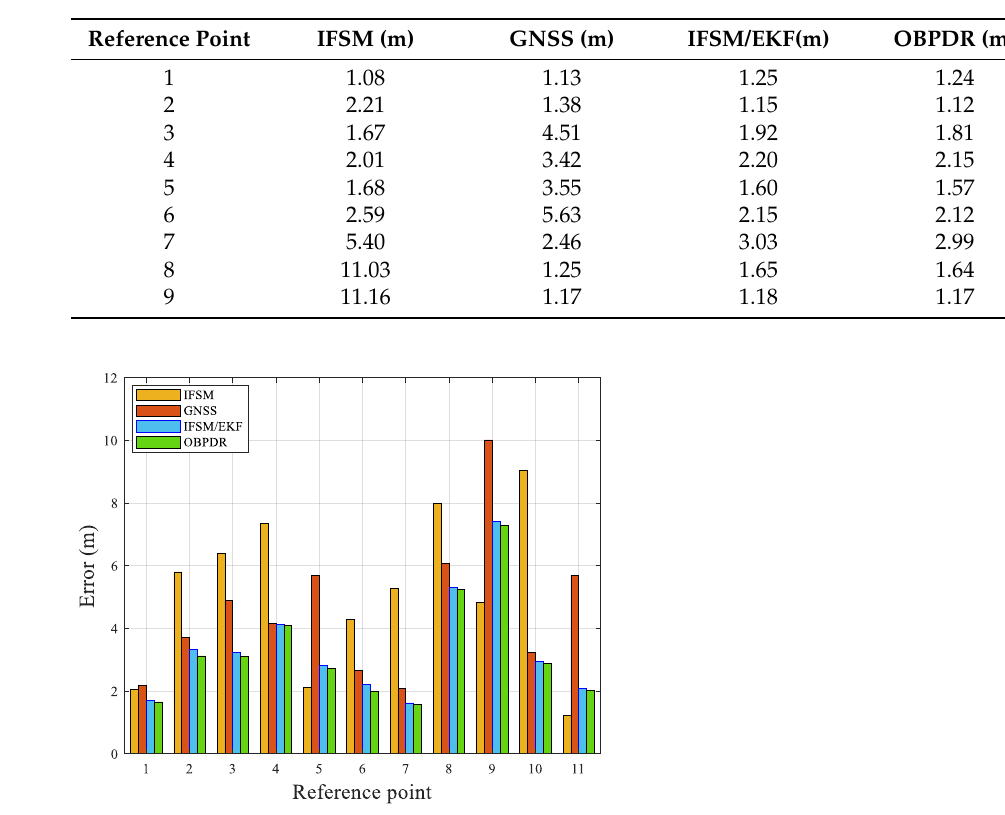
Table 4. Statistics of reference point errors in fountain experiments.